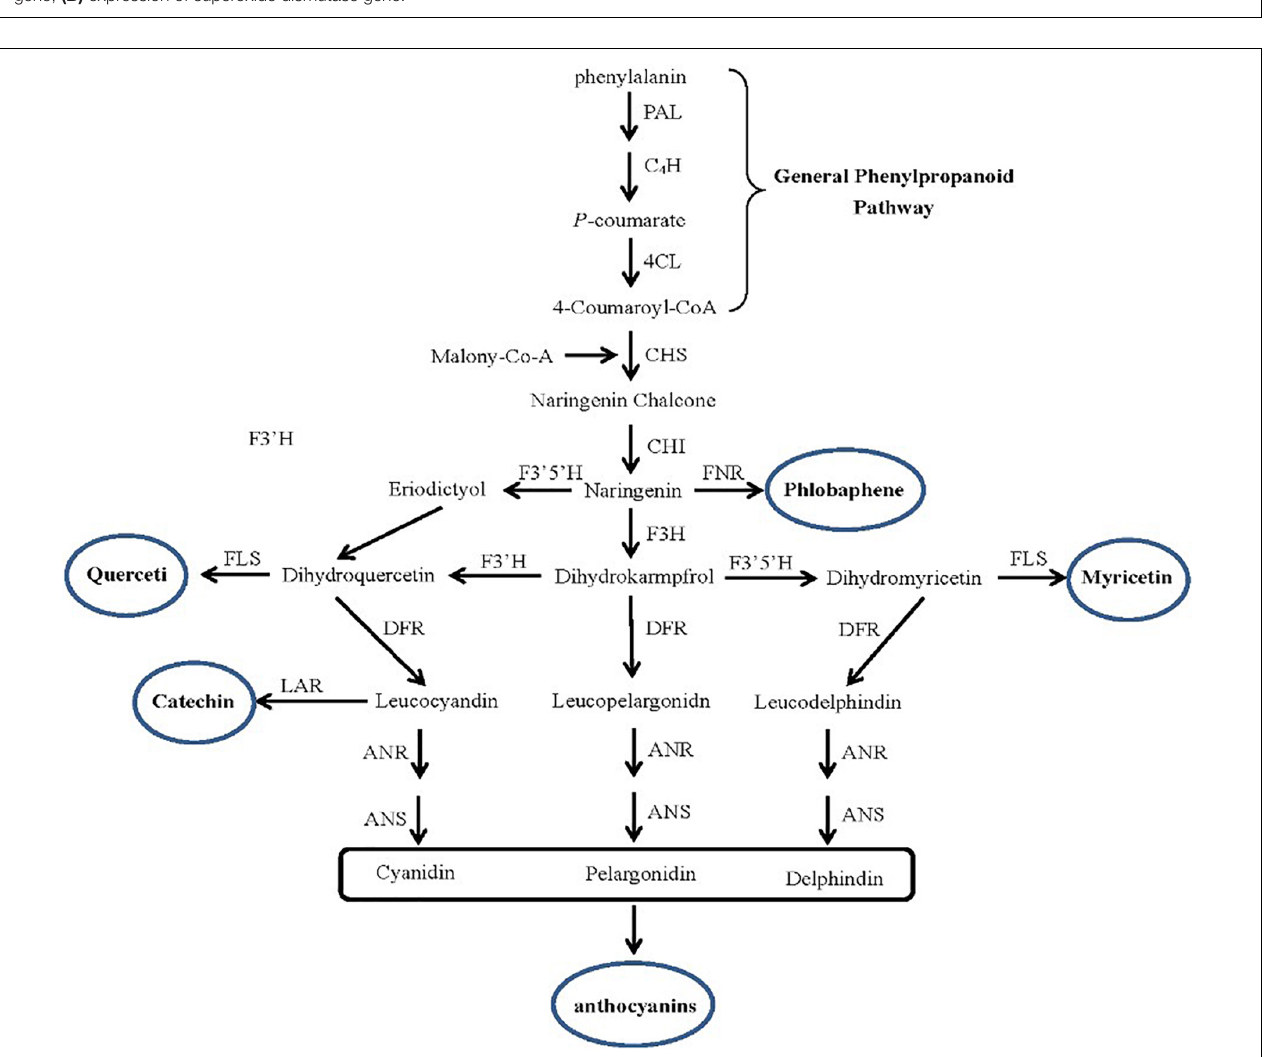
FIGURE 5 | The key genes in the flavonoid synthesis pathway. The DEGs include Chalcone synthase ( CHS ), Chalcone isomerase ( CHI ), Flavanone-3-hydroxylase ( F3H ), Flavanone-3-hydroxylase ( DFR ), Transcriptional activator protein ( ANR ), Anthocyanidin synthase ( ANS ), Coumarate-3-hydroxylase ( C3H ) in invasive plant and hybrid under Cd stress were located in the